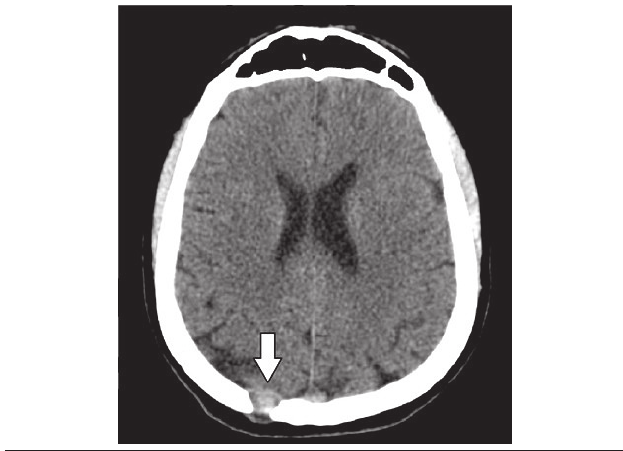
fIgure 2 – Axial section of non-contrast CT scan showing a lesion with soft-tissue attenuation touching the dura mater (white arrow) CT: computed